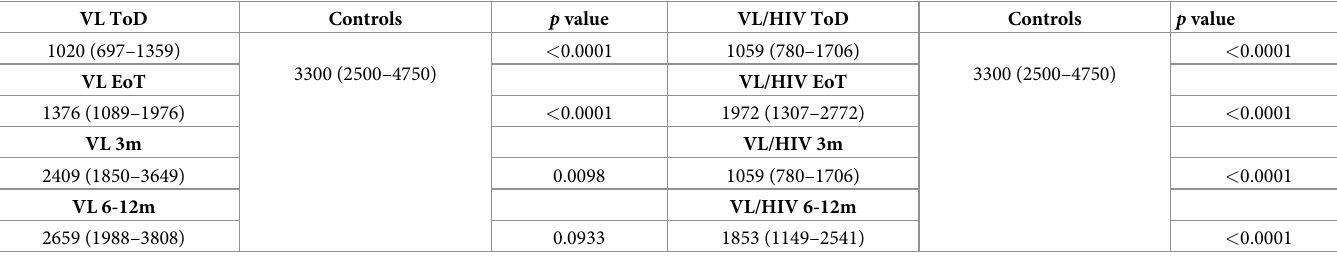
Table 1. Comparison of neutrophil counts between VL and VL/HIV patients and controls over time. VL ToD Controls p value VL/HIV ToD Controls p